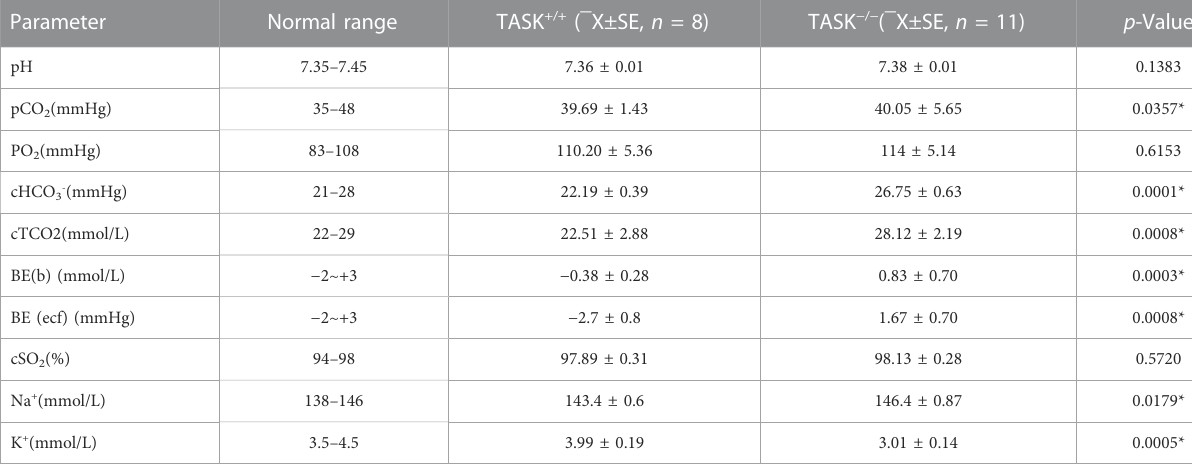
p < 0.05, Table 1). As such, normal diet TASK − / − mice exhibited hypernatremia, hypokalemia and mild acid-base balance disorders despite their pH remaining in the normal range.